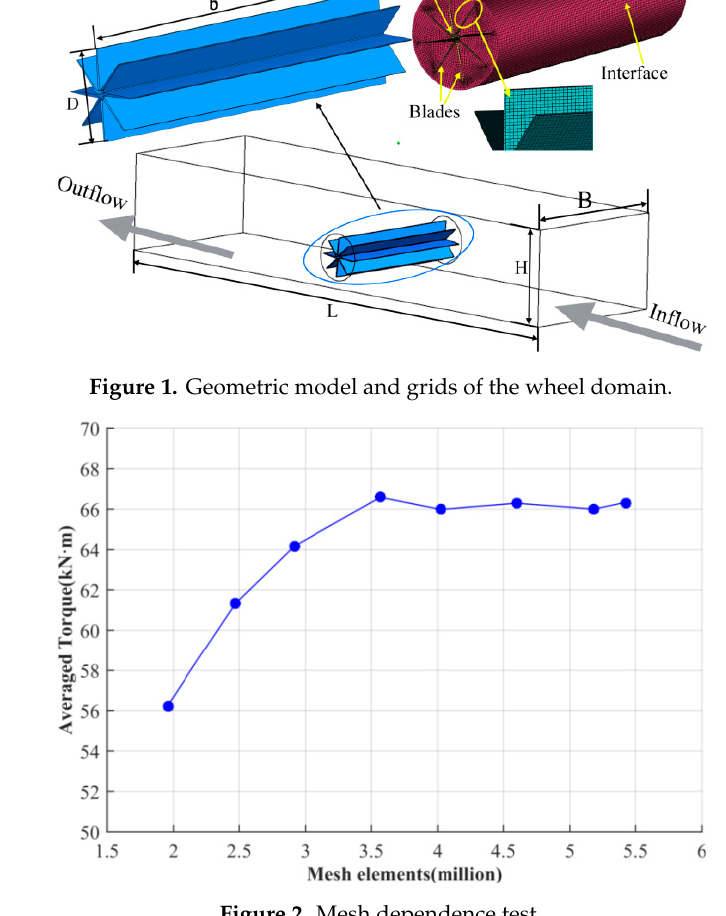
Figure 2. Mesh dependence test.